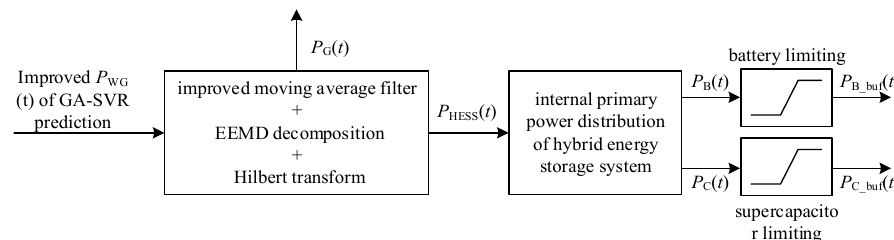
Figure 3. Block diagram of wind ‐ storage cogeneration system .